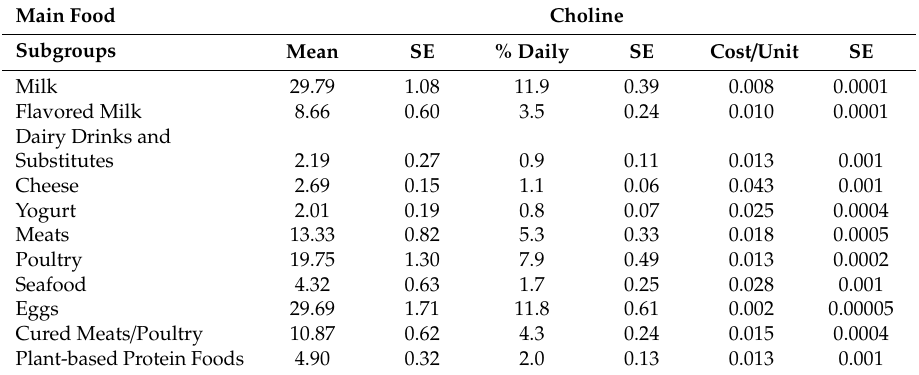
Table 9. Percent daily choline (mg) and cost ($) of choline from eggs in children compared to USDA protein food